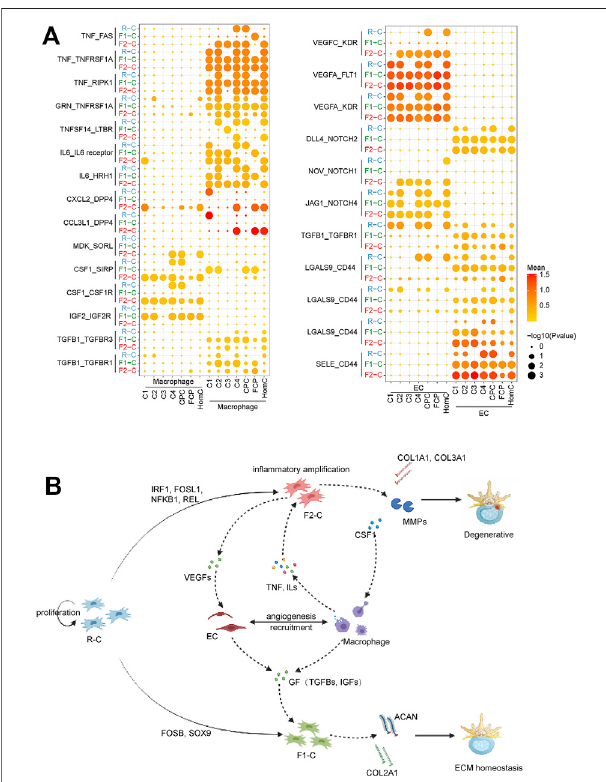
FIGURE 6 | Network of regulatory mechanisms for IVDD. (A) Dot plots depicting ligand – receptor pairs between chondrocytes and macrophage (left) and EC (right). Dot size indicates the percentage of cells expressing the particular genesandthespectrumofcolorrepresentsthemeanaverage expression of the genes. (B) Diagram of the regulatory mechanisms of IVDD found in this study. Solid arrows represent the direction of cell differentiation; dashed arrows represent cytokines and extracellular matrix secreted by